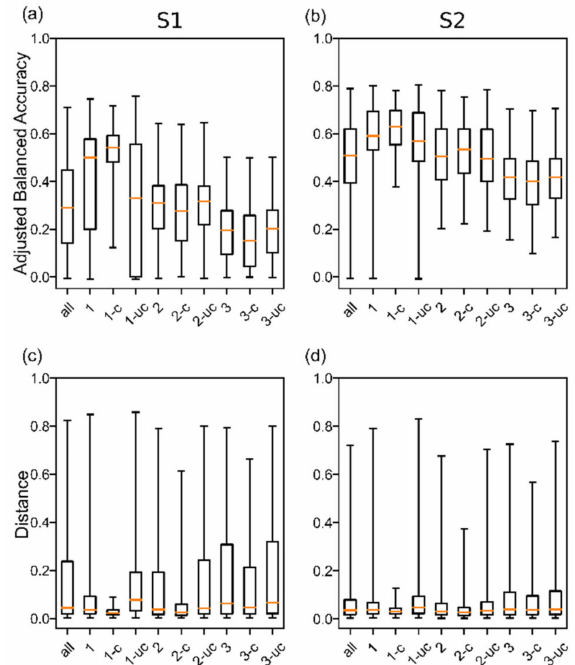
Figure 7. Boxplot distributions of the ABAS ( a ) and distance ( c ) metrics for the 2D S1 configuration, and ( b , d ) for the 2D S2 configuration. The cases are identified by the number of defects and by defect position with “c” referring to centered cases and “uc” to uncentered cases. The distances are normalized values.